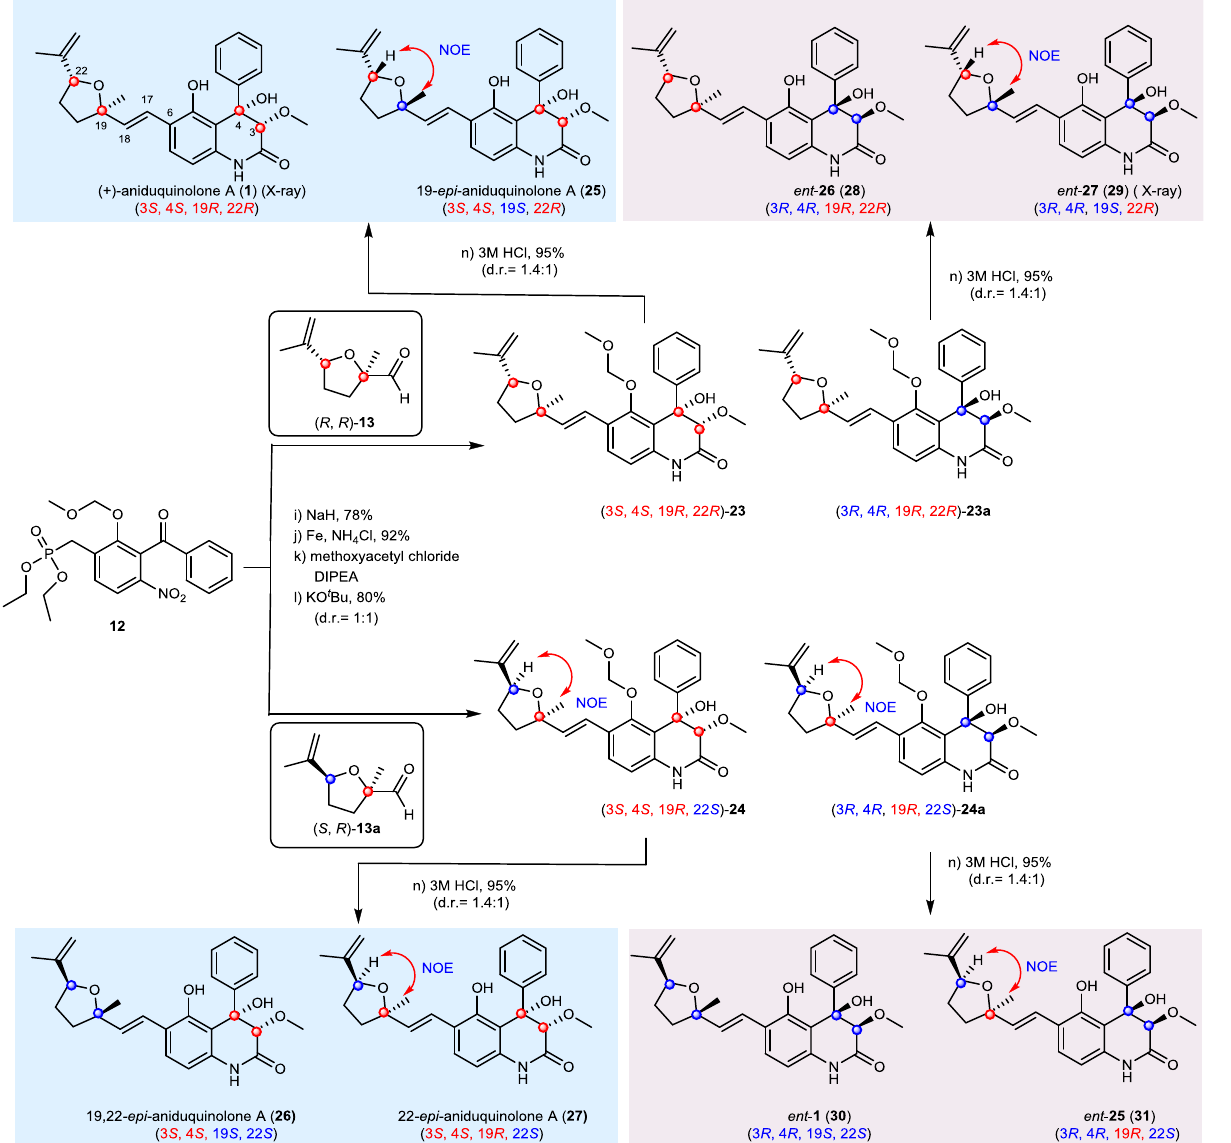
Fig. 4 The syntheses of ( + )-aniduquinolone A (1) and its stereoisomers. With 12 as the common intermediate, the syntheses of 1 and 25 – 31 were